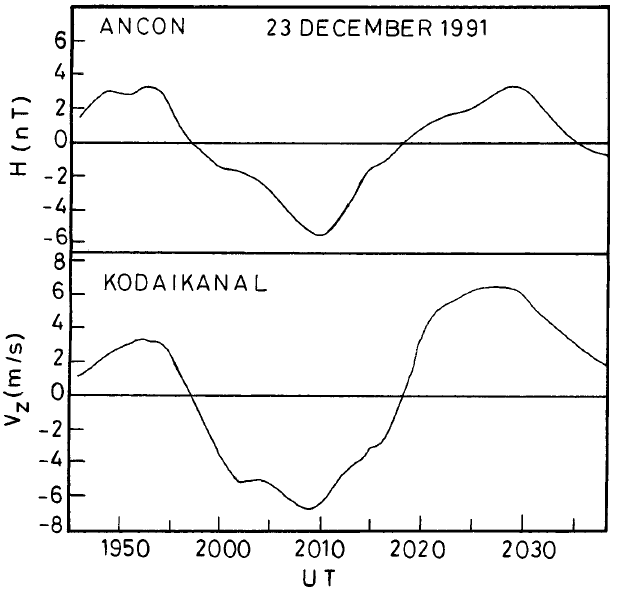
Fig. 3. Variation of geomagnetic H -component and F region vertical plasma drift, V at the dip equatorial stations, Ancon, Peru (dayside) z and Kodaikanal, India (nightside) respectively over the interval 1916– 2038 UT of 23 December, 1991. Note the in-phase relationship of the quasi-periodic fluctuations in the parameters at the